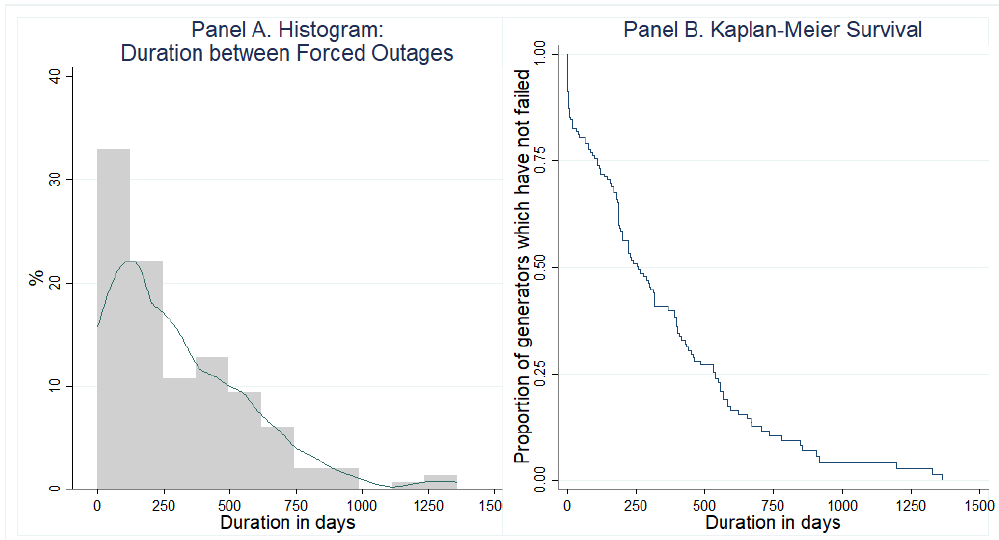
Figure 3. Duration between forced outage and Kaplan-Meier survival curve. Note: Maximum likelihood estimation (MLE) reveals that Exponential distribution fits slightly better to the duration data than Weibull distribution and